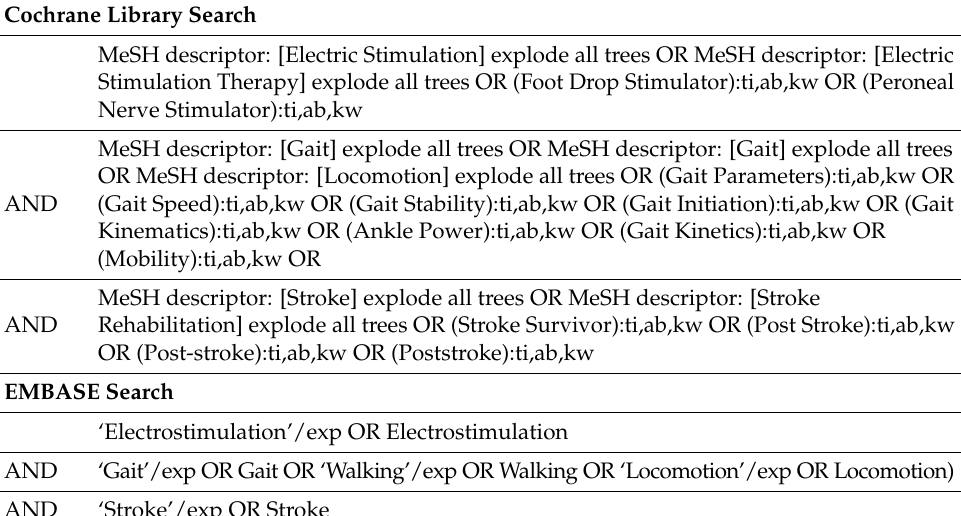
Table 1. Cont . Cochrane Library